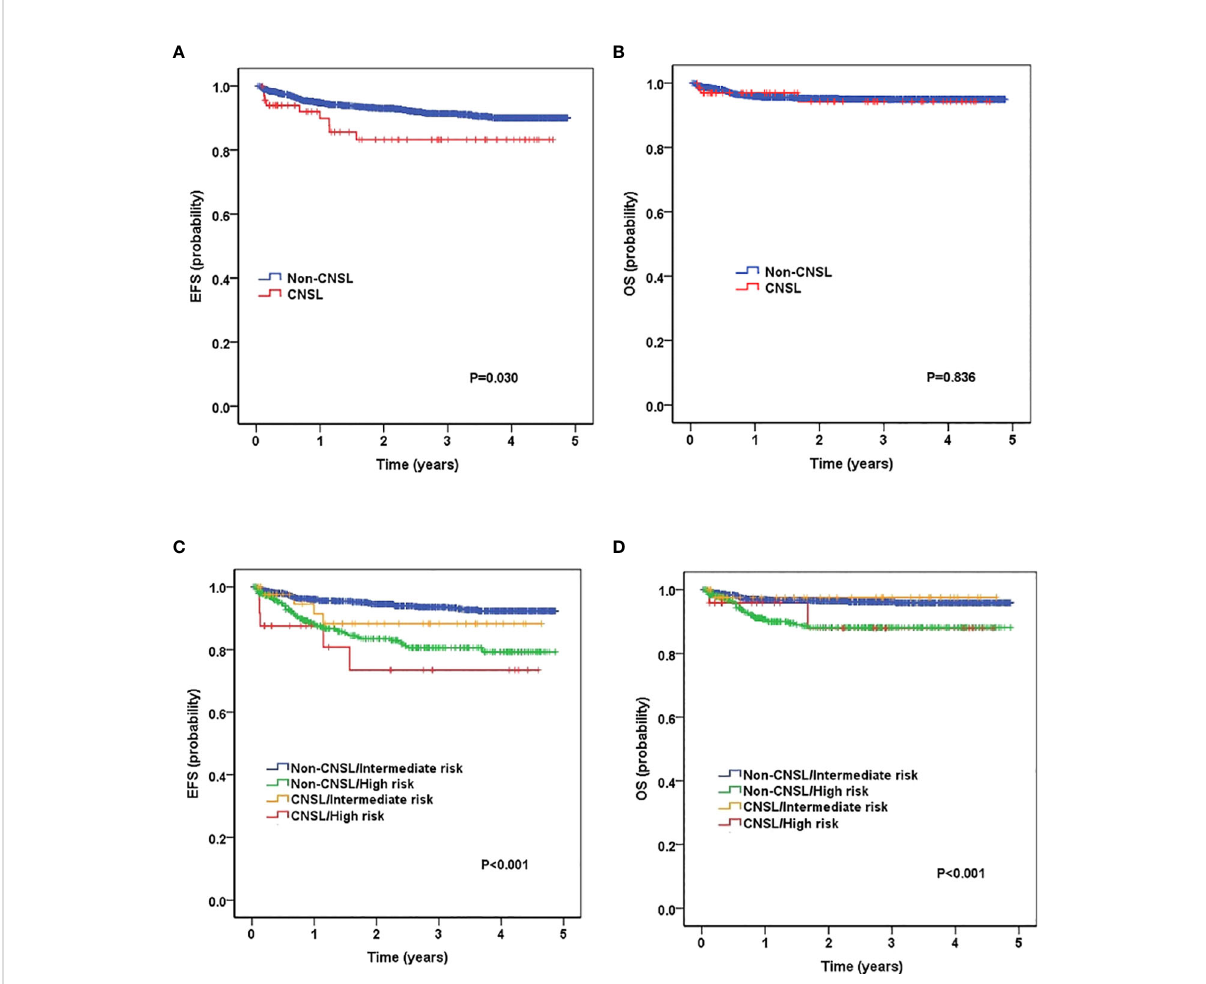
FIGURE 1 Survival curves of childhood B-cell ALL patients according to central nervous system (CNS) status, and according to the combined CNS status and risk strati fi cation. (A) Probability of EFS (event-free survival) for patients with CNSL and non-CNSL at diagnosis. (B) Probability of overall survival (OS) for patients with CNSL and non-CNSL at diagnosis. (C) Probability of EFS for patients according to the combined CNS status and risk strati fi cation. (D) Probability of OS for patients according to the combined CNS status and risk strati fi